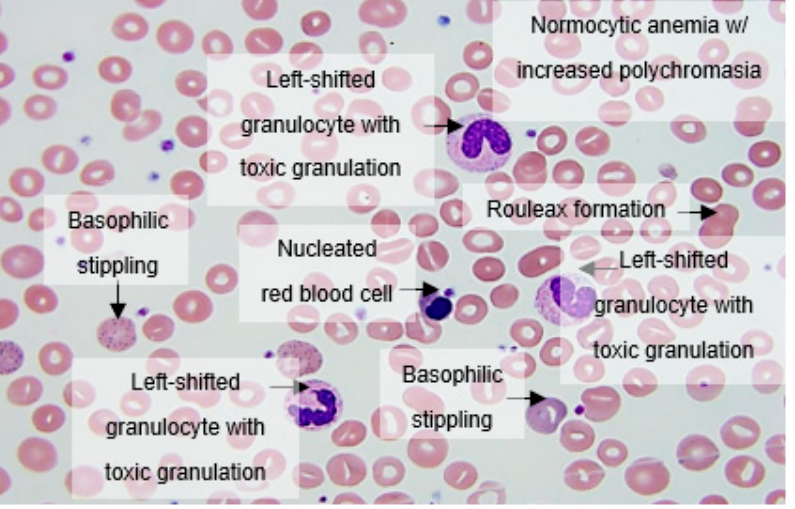
Figure 1. Peripheral blood smear analysis showing increased rouleaux formation, normocytic anemia with increased polychromasia, nucleated red blood cells, basophilic stippling, left-shifted granulocytes with toxic granulations, lymphopenia, and thrombocytopenia.